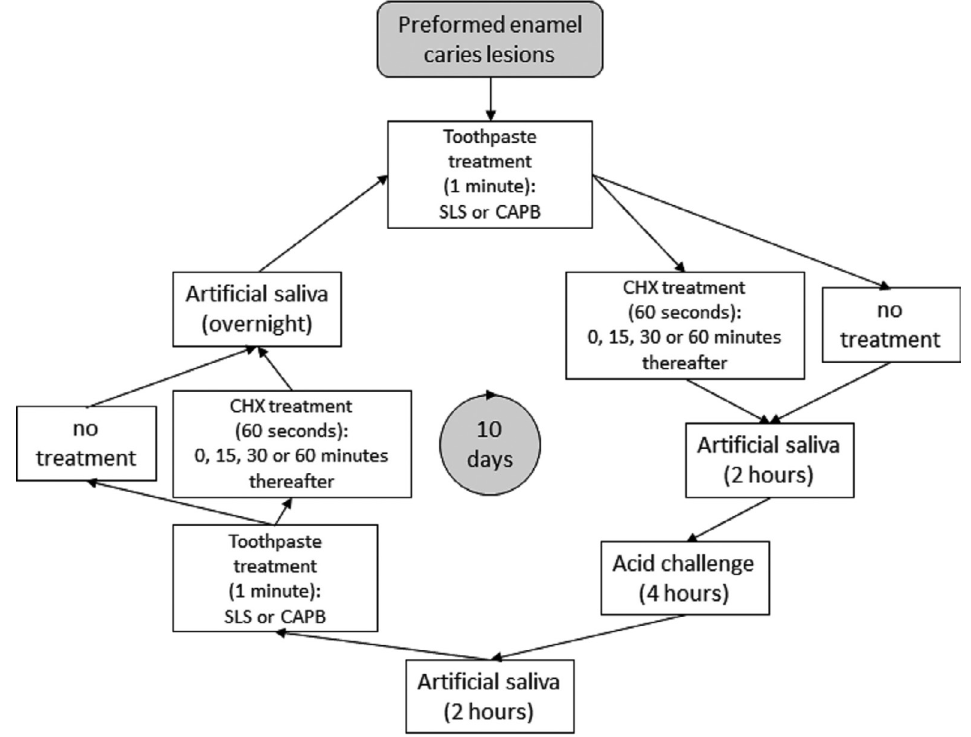
Figure 1- Schematic representation of the pH-cycling